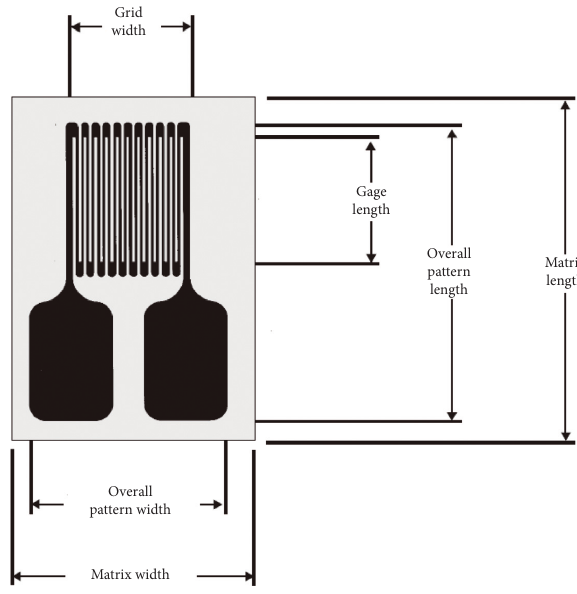
Figure 1: Gauge dimensions. Table 4: Data sheet of the strain